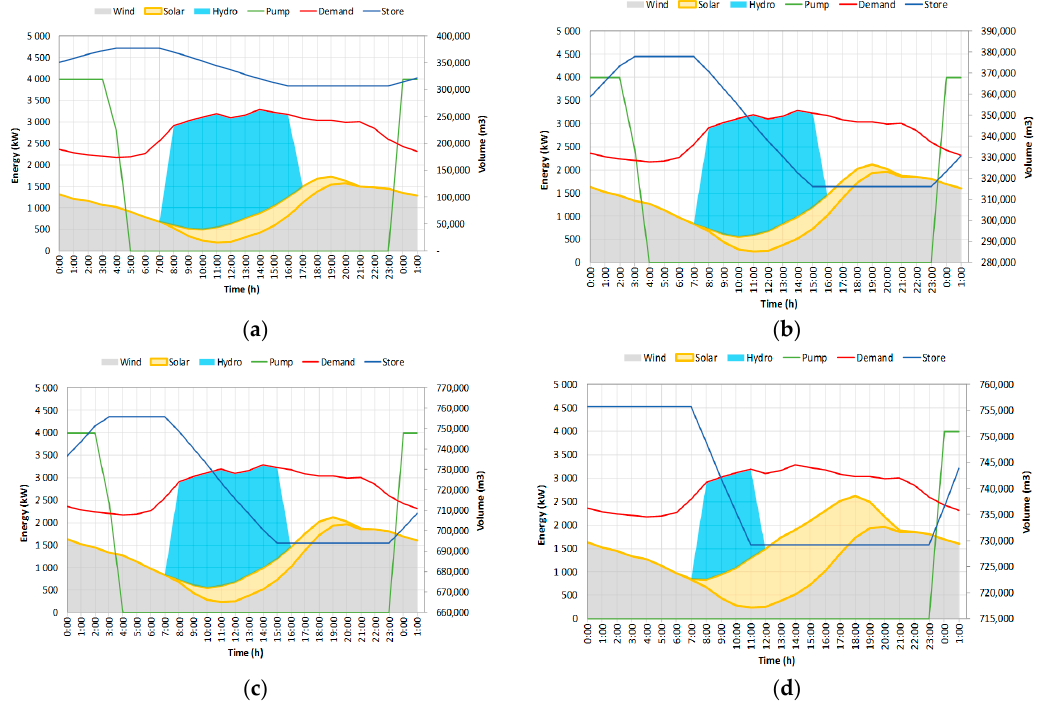
Figure 14. Energy contribution on summer day: ( a ) scenario 1; ( b ) scenario 2; ( c ) scenario 3; ( d ) Figure14. Energycontributiononsummerday: ( a )scenario1; ( b )scenario2; ( c )scenario3; ( d scenario 4.